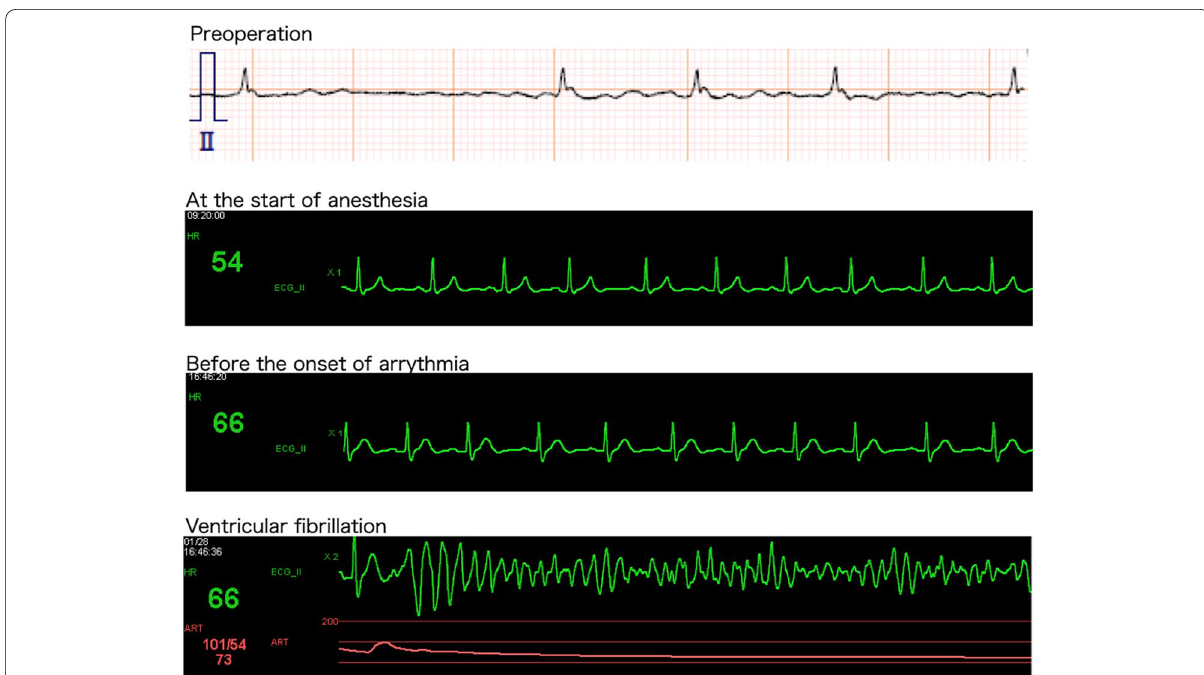
Fig. 1 Electrocardiogram lead II. Atrial fibrillation converted to sinus rhythm after induction of general anesthesia and during surgery. Ventricular fibrillation developed when the surgeon touched the carotid